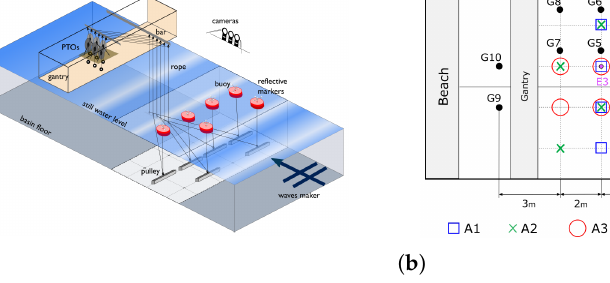
Figure 14. Experimental setup used by Giassi et al.: ( a ) sketch of the setup’s components, reprinted with permission from Ref. [45], 2020, Giassi et al.; ( b ) wave basin WEC array layout, reprinted with permission from Ref. [8], 2019, Giassi et al.; ( c ) the University of Plymouth’s COAST Lab setup, reprinted with permission from Ref. [8], 2019, Giassi et